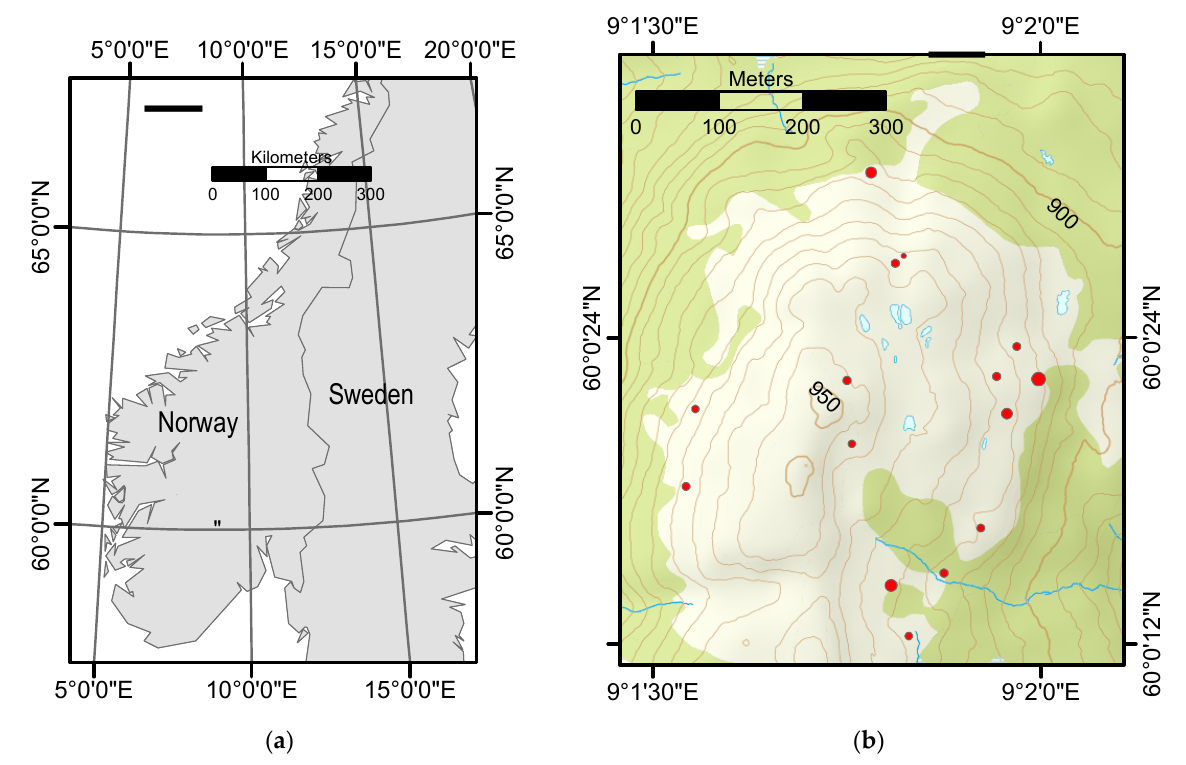
Figure 1. ( a ) Location of the study site in southern Norway (black square). ( b ) Selected Norway spruce tree objects (red circles). The different sizes of the red circles represent the downward-looking pyranometer’s footprint projected at ground for the different tree objects according to the UAV flight height (see Equation (3)). The green areas are classified as forest areas according to the official N50 topographic map series. Accordingly, the light area is above the treeline. Contour interval is 5 m.